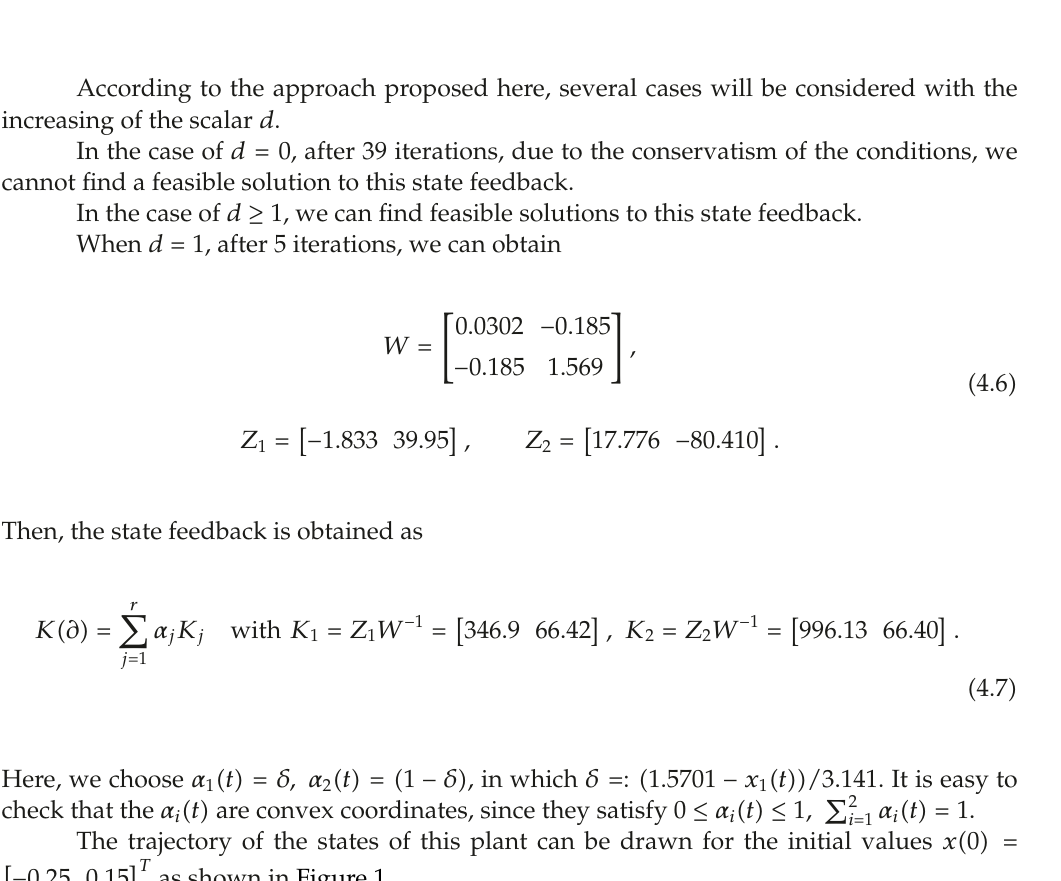
Figure 1: Trajectory of the states of this plant with initial values x (cid:2) 0 (cid:3) (cid:8) (cid:4) − 0 . 25 0 . 15 (cid:5) T